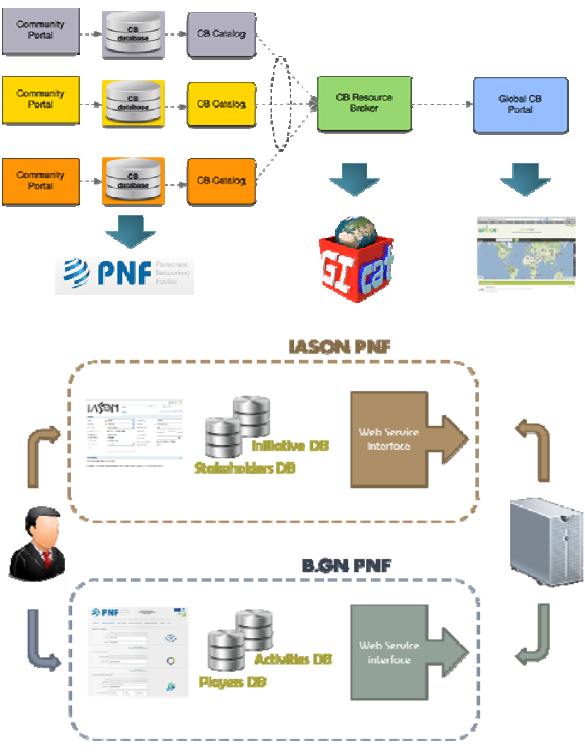
Figure 9. IASON PNF Brokered